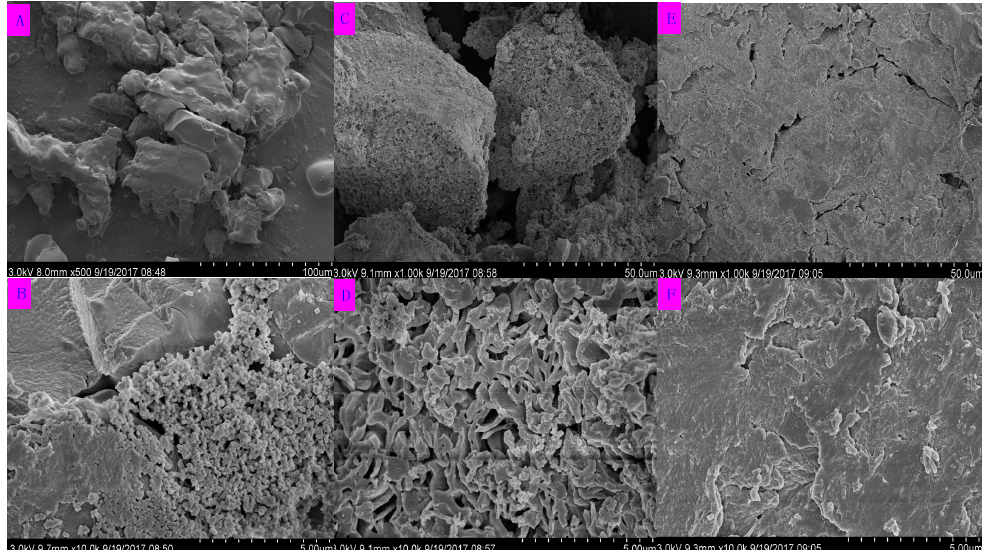
Figure 4. Surface morphology of CS ( A , B ), QCS ( C , D ), DQCS ( E , F ).